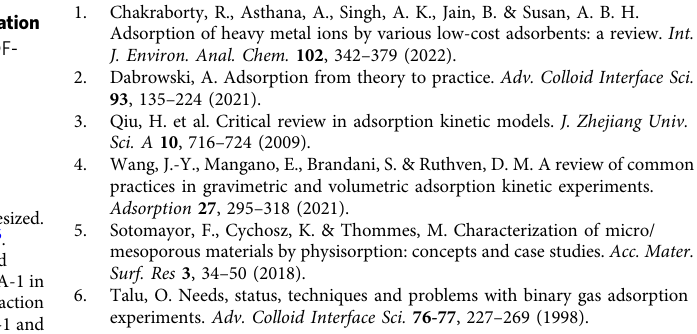
MOF synthesis MIL-88A(Fe) . MIL-88A(Fe) samples with different particle sizes were synthesized. For that, already reported protocols were used with some modi fi cations 39,46 . Brie fl y, iron(III) chloride hexahydrate (1.381 g, 5.11 mmol) and fumaric acid (0.593 g, 5.11 mmol) were dissolved in a mixture of 25mL of solvent: MIL-88A-1 in